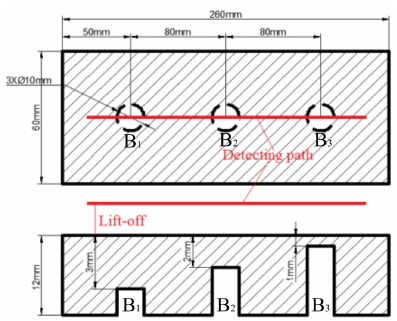
Figure 10. Schematic diagram of a 12 mm thick fiberglass board containing flat bottomed holes of buried depth (from left to right) 3 mm, 2 mm and 1 mm.